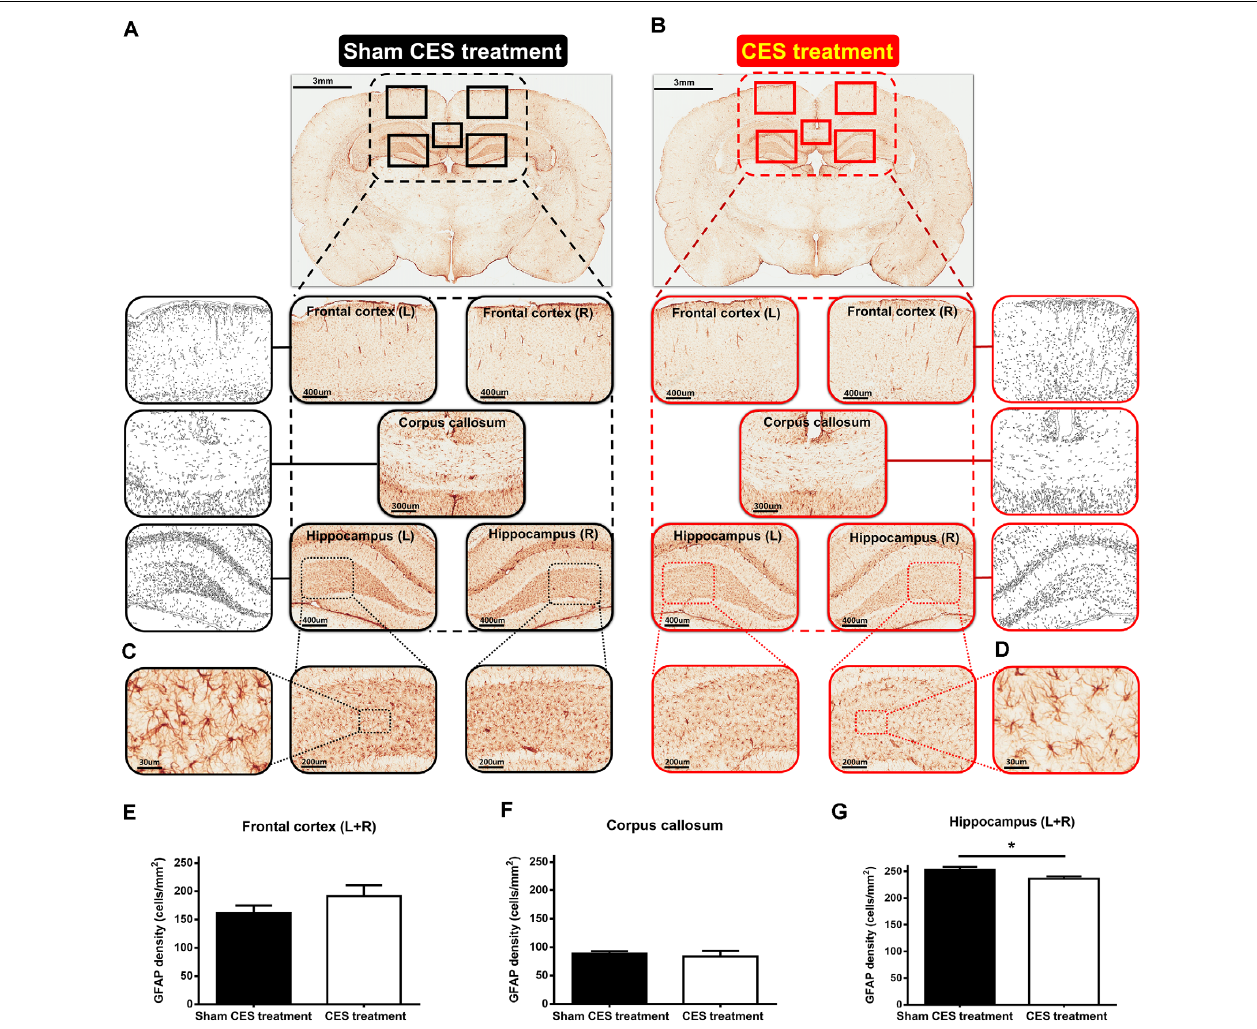
FIGURE 7 | (A,B) Representative of glial fibrillary acidic protein (GFAP) immunostaining and example of GFAP images to a binary image in the frontal cortex (L + R, Magnification, × 50; Scale bars = 400 µ m), corpus callosum (Magnification, × 50; Scale bars = 300 µ m), and hippocampus (L + R, Magnification, × 50; Scale bars = 400 µ m) in TBI rat with sham CES treatment and TBI rat with 4 weeks of CES treatment. (C,D) Representative views of the morphology of GFAP-positive cells in the hippocampus (Magnification, × 300; Scale bars = 30 µ m). (E–G) The averaged data (L + R) of the density of GFAP-positive cells in the frontal cortex,